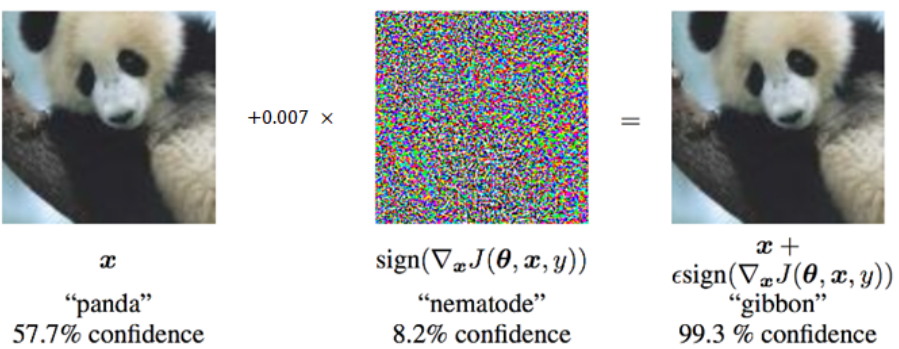
Figure 17. Demonstration of adversarial example generation by adding an imperceptible vector applied to GoogLeNet for the ImageNet dataset.